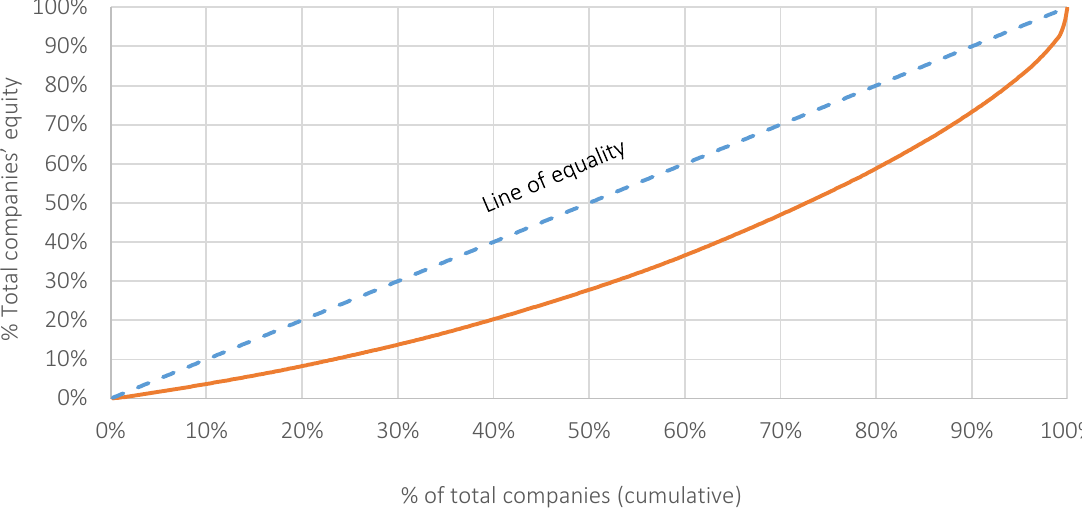
Figure 11. Lorentz curve of companies’ equity after 40 periods in a conventional LBO